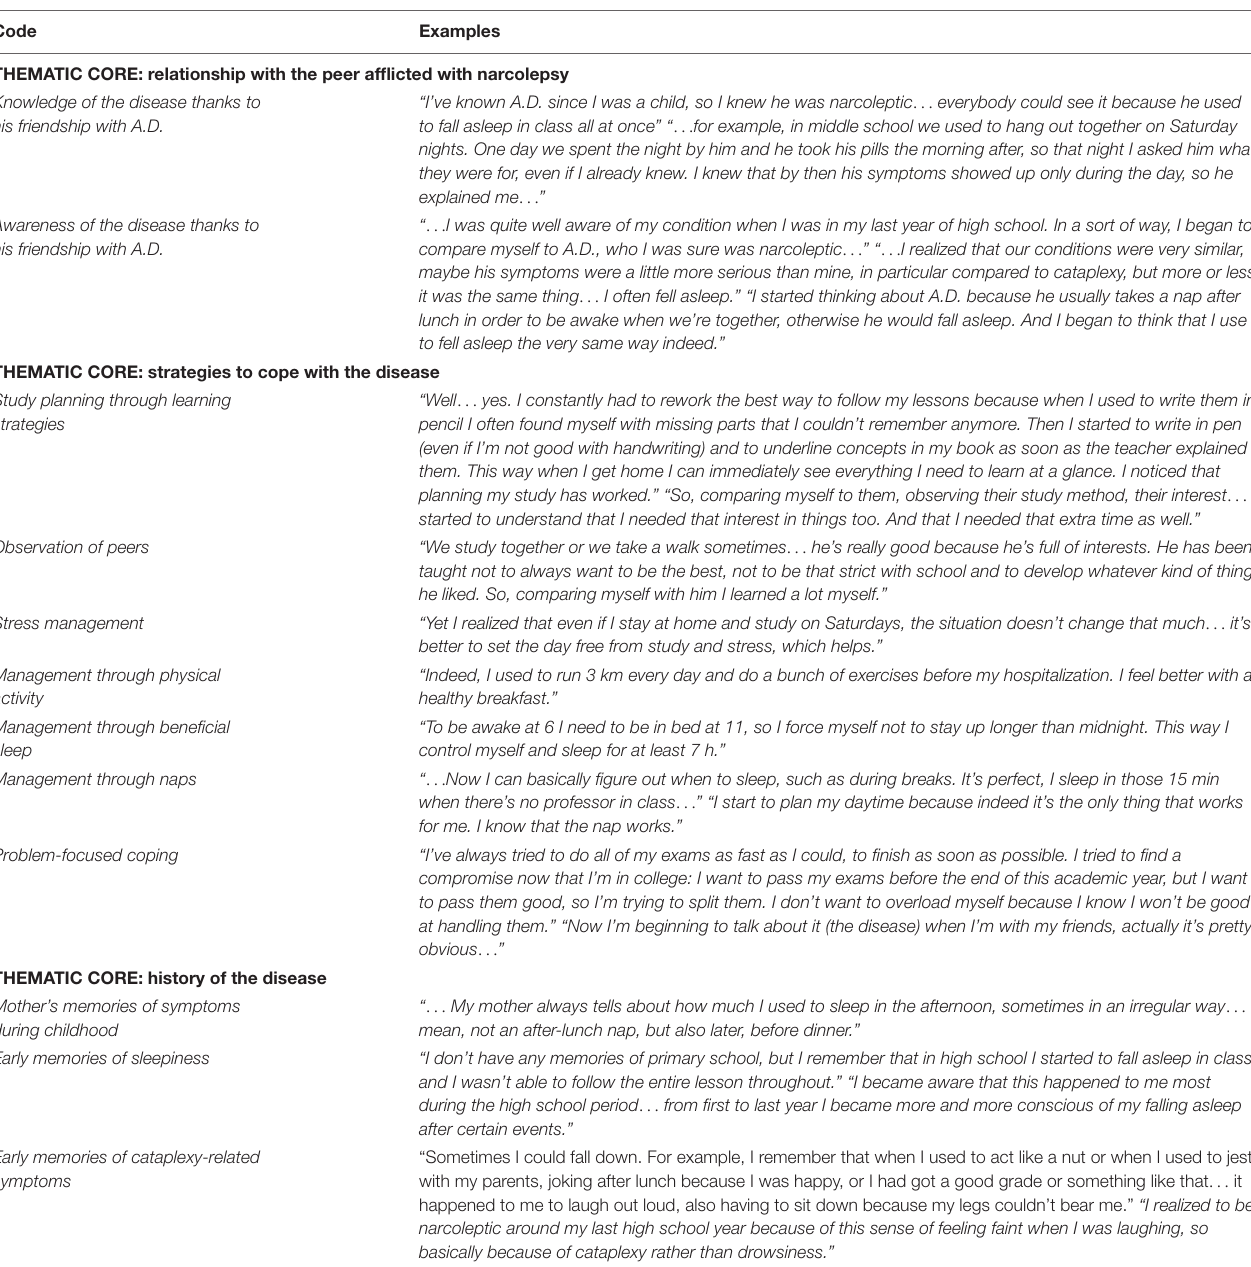
TABLE 3 | Example sentences for each thematic core and codes from the patient interview. Code